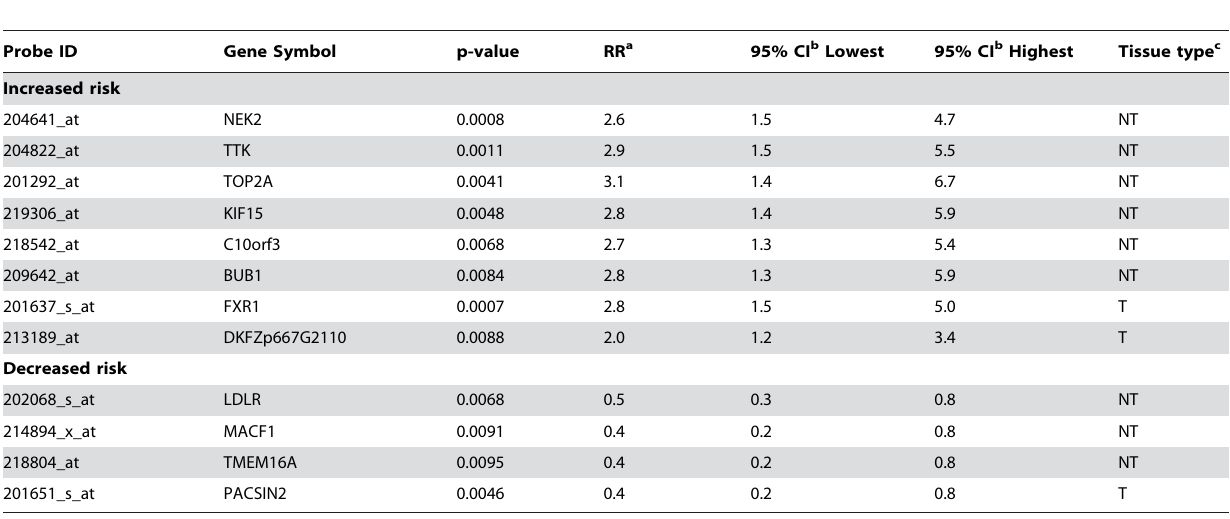
Table 3. Mortality risk in smokers for gene expression differentiating current from never smokers (C/N) in lung tumor and non- tumor tissue samples (p ,